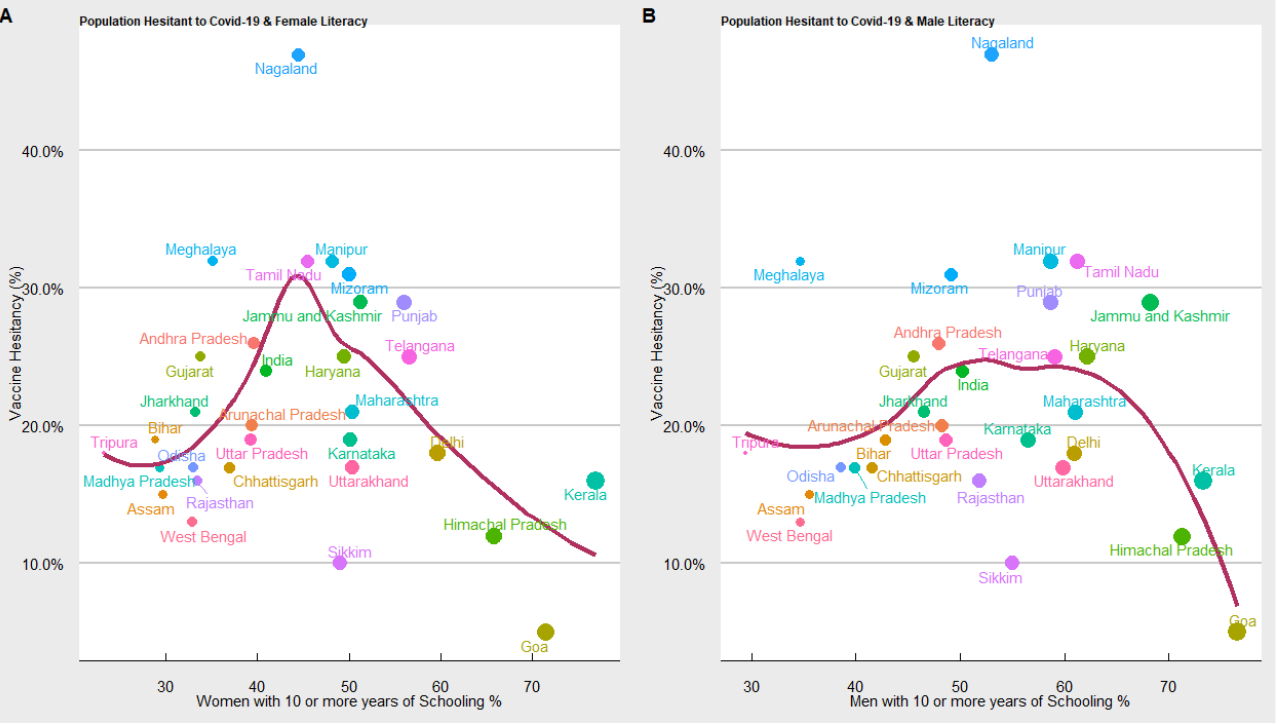
Figure 8. Results of vaccine hesitancy and literacy.